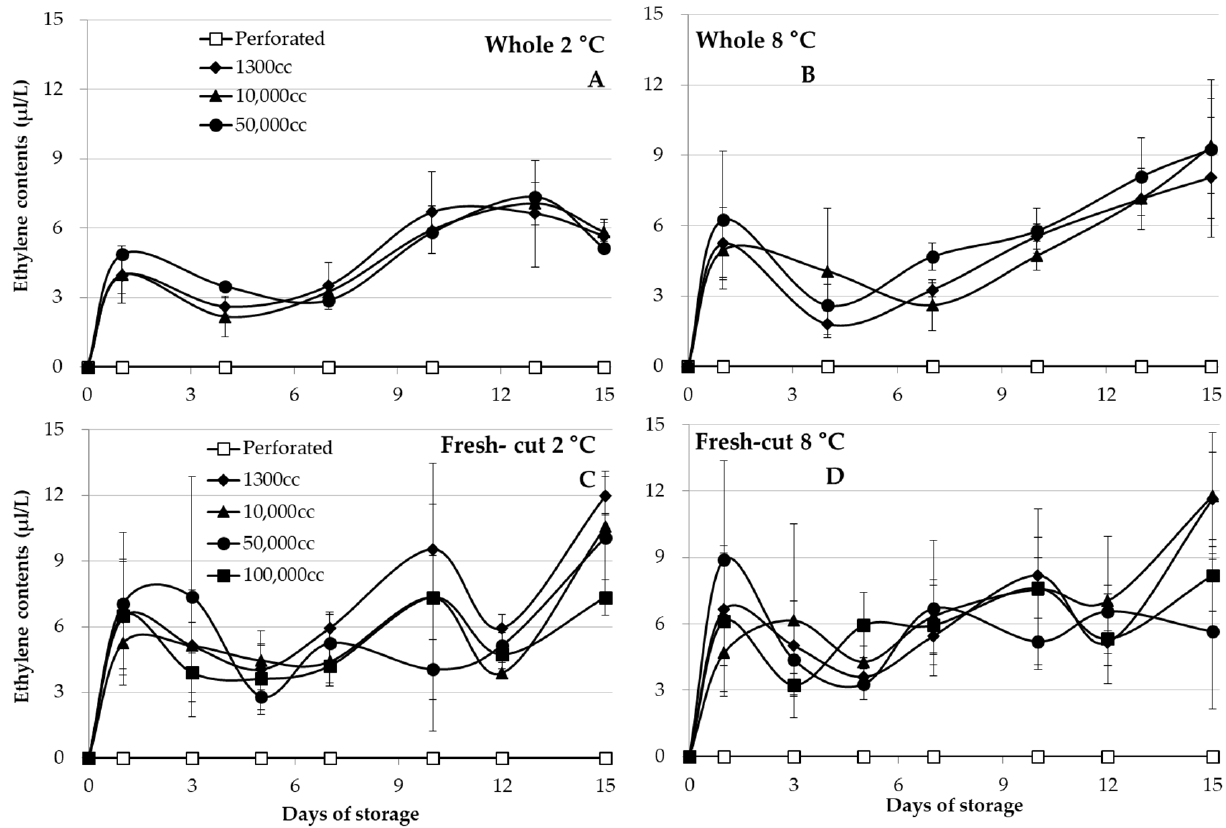
Figure 3. The ethylene contents of whole ( A : 2°C and B : 8°C) and fresh-cut ( C : 2°C and D : 8°C) romaine lettuce in OTR film (1300 cc; 10,000 cc; 50,000 cc; 100,000 cc·m − 2 ·day − 1 ·atm − 1 ) in MA storage at 2 and 8 °C for 15 days. Vertical bars represent ± SD of the means ( n = 5).